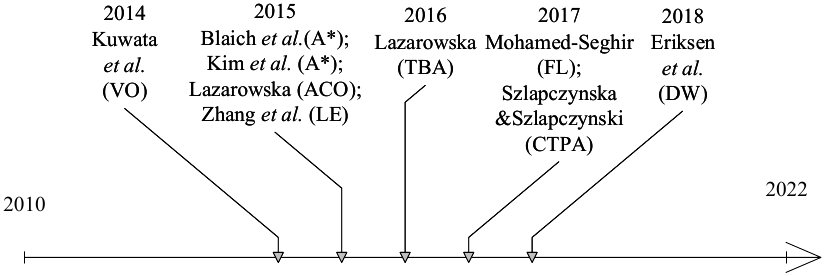
Figure 6. Timeline showing compared approaches from the years 1997–2010.